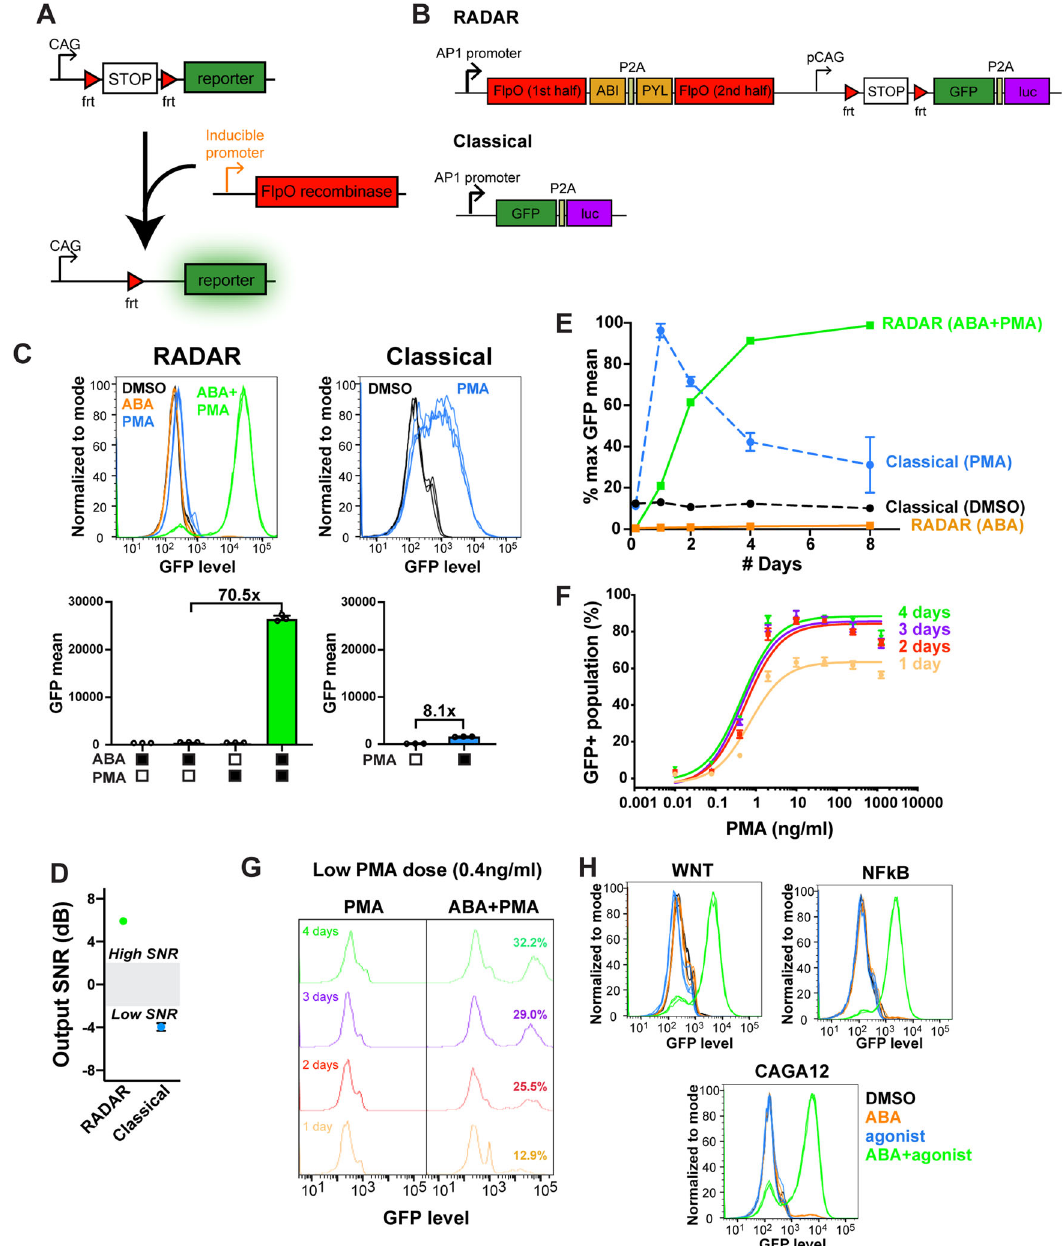
Fig. 1 Development of RADAR. A Schematic of how RADAR functions. The primarily tested inducible promoter in this study was sensitive to AP-1, though the system is also shown to be compatible with other promoters (WNT, NF-kB, or CAGA12). B Construct comparison between RADAR and a classical reporter. C Regulation of reporter-driven GFP expression using combinations of ABA, PMA, and DMSO (vehicle control) ( n = 3, mean ± s.d.). D Signal-to- noise ratios of RADAR and classical reporters when comparing “ on ” (ABA/PMA for RADAR, PMA for classical) and “ off ” (ABA for RADAR, DMSO for classical) signals ( n = 3, mean ± s.d.). E Retainment of GFP expression over time with comparison between RADAR and classical reporters ( n = 3, mean ± s.d.). F Dose response of RADAR measured after 1, 2, 3, and 4 days ’ of incubation in ABA and PMA ( n = 3, mean ± s.d.). G Sensitivity of RADAR to a low dose of PMA (0.4 ng/ml) over time with an increasing percentage of cells switching “ on ” . H Application of RADAR to other pathway-sensitive